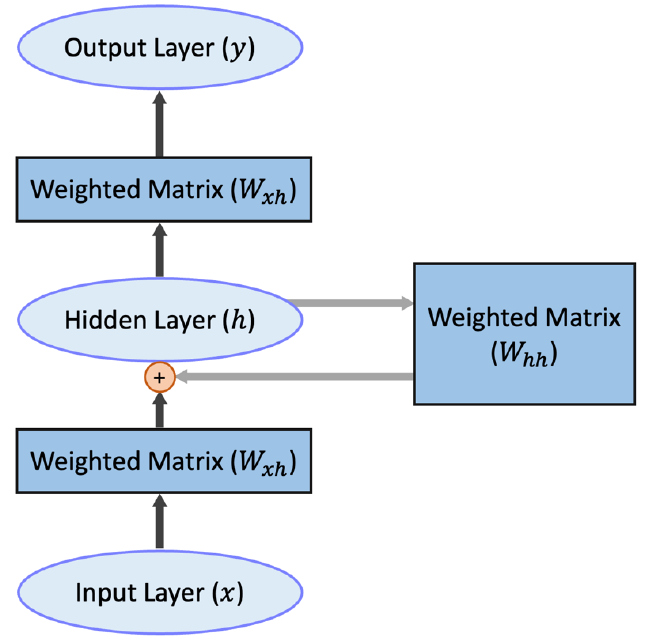
Figure 8. The structure of RNN. The plus sign means the hidden layer ℎ is produced by 𝑊 ℎℎ and 𝑊 𝑥ℎ together. The black arrows represent the fully connected part, and the gray arrows represent the recurrent part.